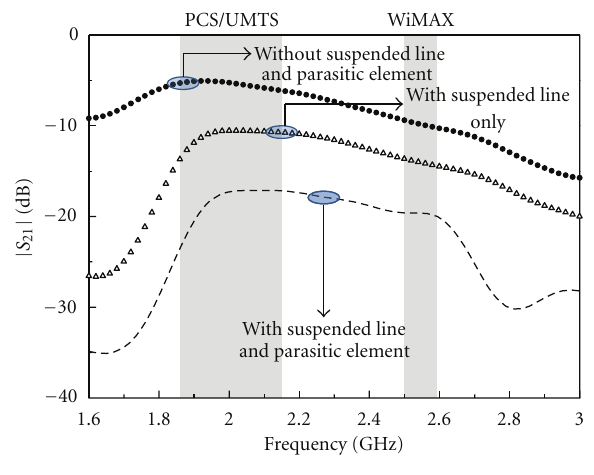
Figure 3: Simulated isolations ( S 21 ).